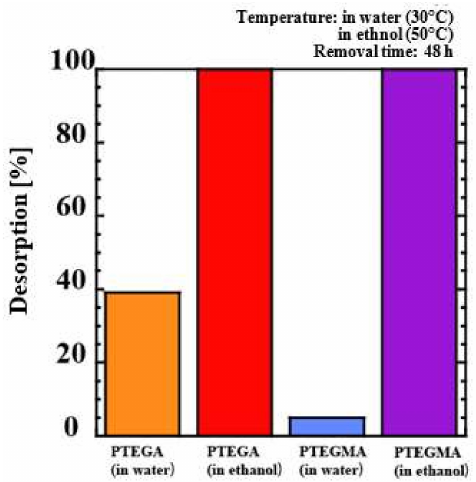
Figure 7. Desorption of BPA by the POEGA and POEGMA